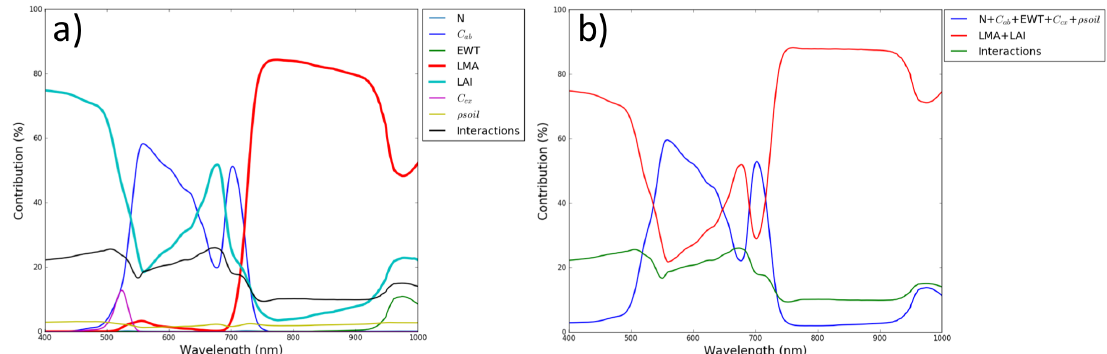
Figure 3. Results of the EFAST study illustrating how variation in PROSAIL inputs affects the output reflectance. The SA is only reported for wavelengths in the VNIR (400–1000 nm). In ( a ) we have plotted the contribution of each individual PROSAIL model input, while in ( b ) we have combined the model parameters of interest for our study (LMA and LAI) and all other inputs. The results from the SA provided us with the range of wavelengths (400–500 nm and 720–1000 nm) to perform the inversion, where the contribution by LMA and LAI is significantly higher than all other model inputs.